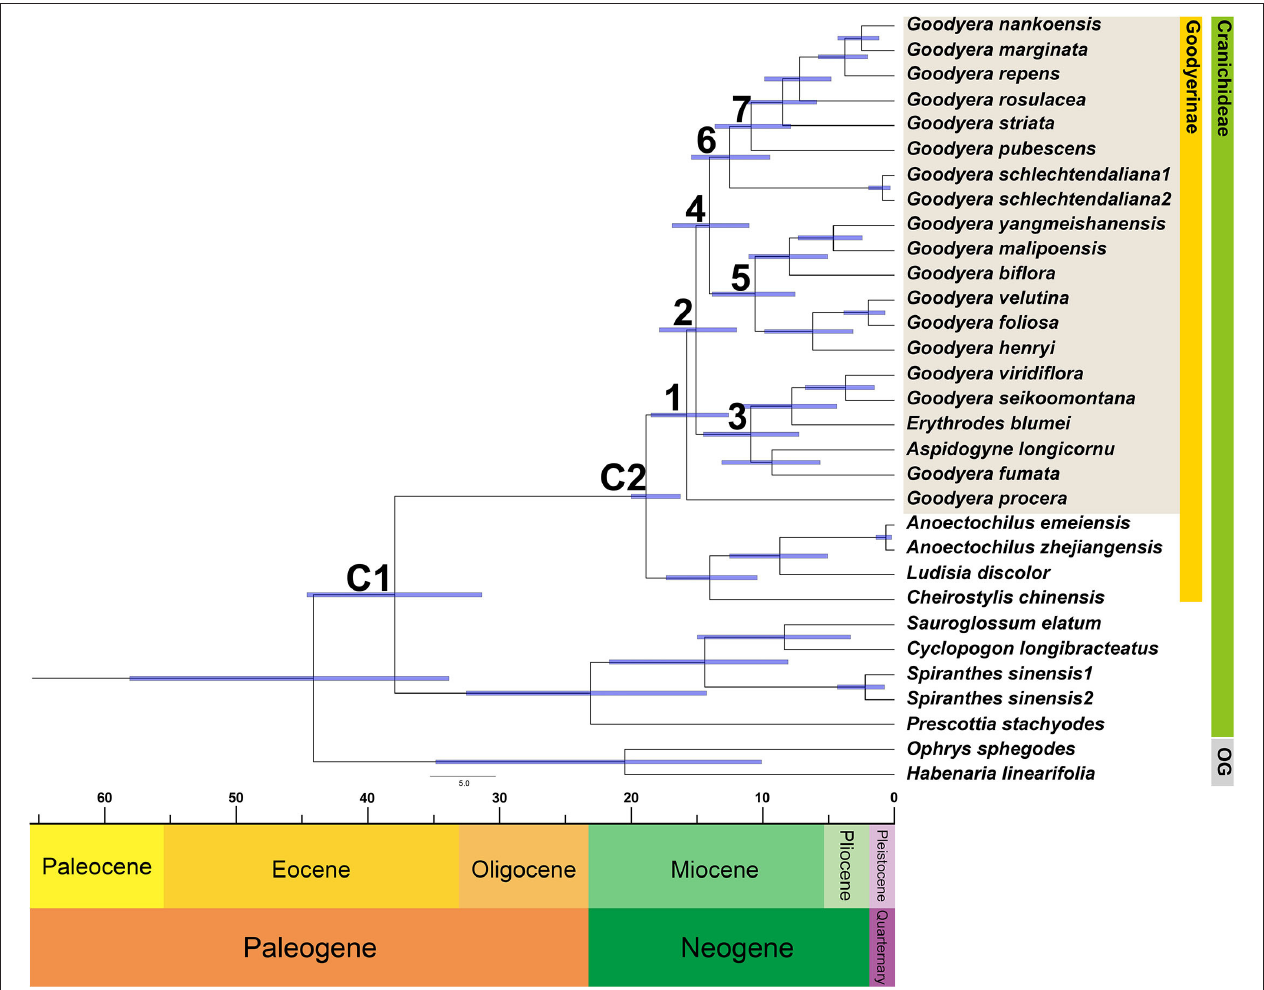
FIGURE 4 | Chronogram showing the divergence times estimated in BEAST based on the combined 14 plastid DNA regions. The divergence times of the clades and subclades are shown near each node. Numbers 1–7 indicate nodes of interest (refer to Table 3 for details). Nodes labeled C1 and C2 are the calibration points used in the analysis (for details, refer to the Section “Materials and Methods”). Blue bars represent 95% highest posterior density for the estimated mean